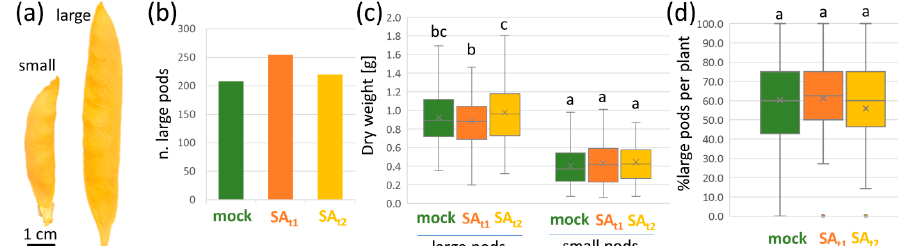
Figure 2. Salicylic acid promoted the growth of seed pods. ( a ) Representative images of collected seed pods classified as small and large (more than 6 cm in length); ( b ) Number of seed pods classified as large; ( c ) Box plot representations of seed weight per pod; ( d ) Percentages of large seed pods per plant including median (line) and mean values (cross). Data are based on 75 plants per experimental condition; the letters represent significant differences ( p < 0.05, Kruskal–Wallis and Conover’s test, p < 0.05). 2.3. Seed Proteome Analysis Did Not Show Striking Differences in Total Proteome Composition Nine plants per experimental condition were randomly selected, and all their seeds were homogenized and extracted. The proteome analysis of collected seeds provided the identification and quantitation of 3119 and 1796 proteins, respectively. The functional analysis of the corresponding Arabidopsis orthologs showed that the most numerous cate- gories were protein metabolism, carbohydrate metabolism enzymes (CAZymes), stress- related proteins, and RNA metabolism, representing more than 900 proteins in total (Fig- ure 3a). The seed composition based on the estimated protein abundances showed that the majority of the seed proteome was formed by storage proteins (76%), proteins of lipid metabolism (6%), stress response (5%), protein metabolism (4%), and CAZymes (3%) (Fig- ure 3b). Next, the effect of salicylic acid treatment on seed proteome composition was compared (Figure 3c). Average changes in protein categories were relatively low, and there was no significant impact on the most abundant category (seed storage proteins). However, the comparison showed significant differences ( p < 0.05) in most other catego- ries, including protein metabolism, CAZymes, RNA metabolism, redox metabolism, transport, and lipid metabolism (Figure 3c).